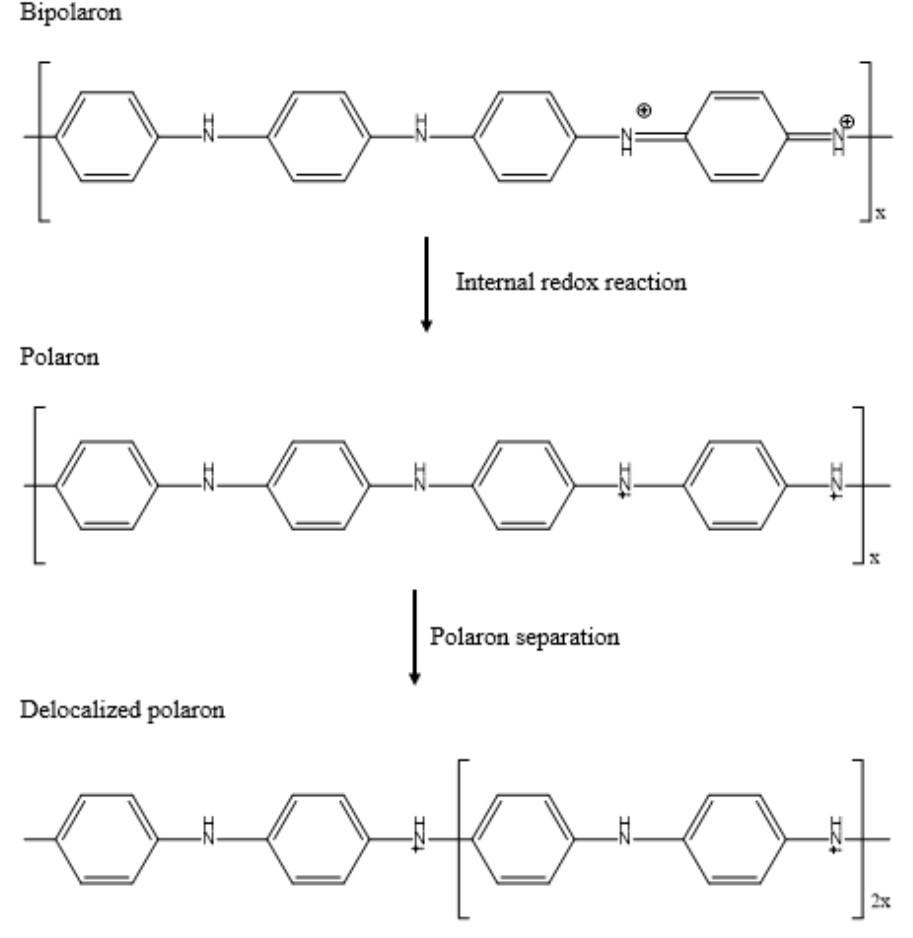
Figure 4. Bipolaron and polaron interconversion in emeraldine PANI.